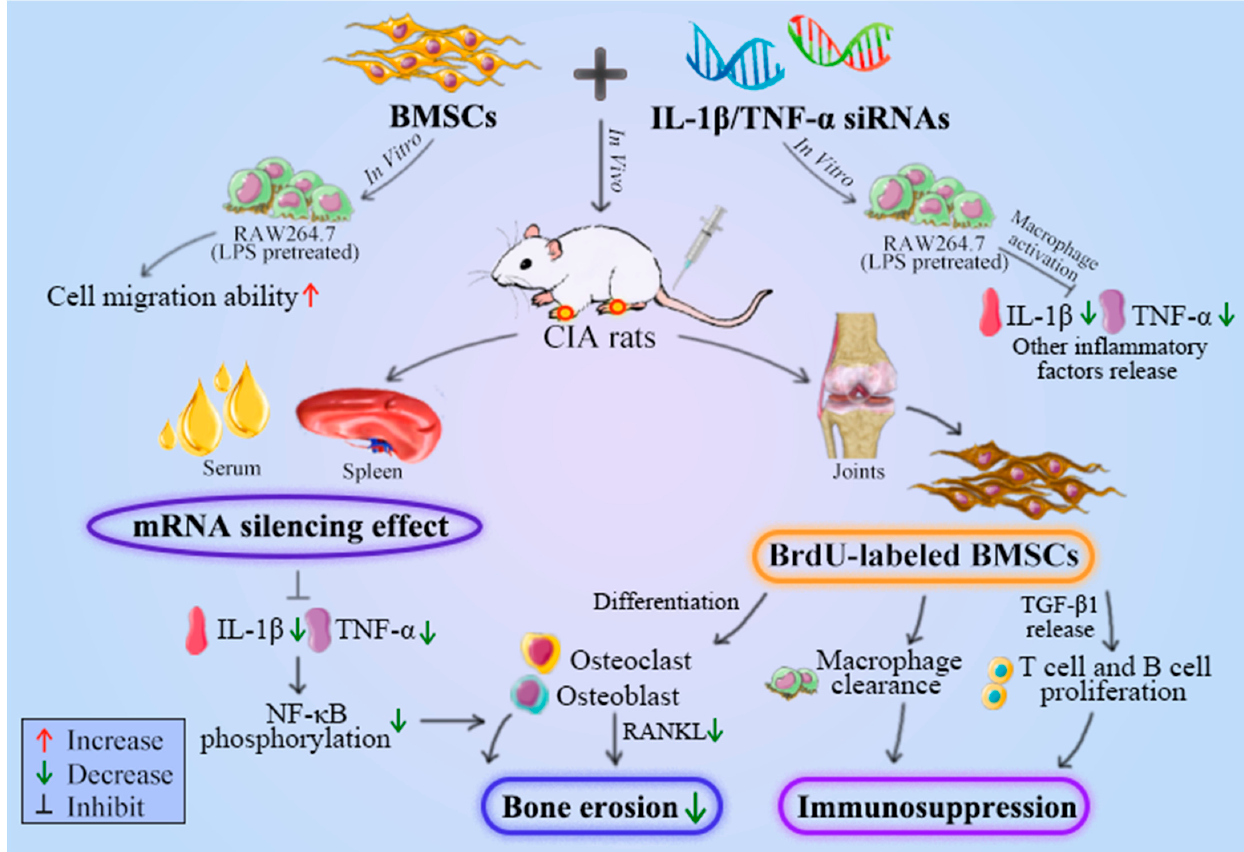
Figure 5. Schematic representation of proposed mechanism responsible for IL-1 β /TNF- α -siRNAs combined with BMSCs mediated treatment of RA.